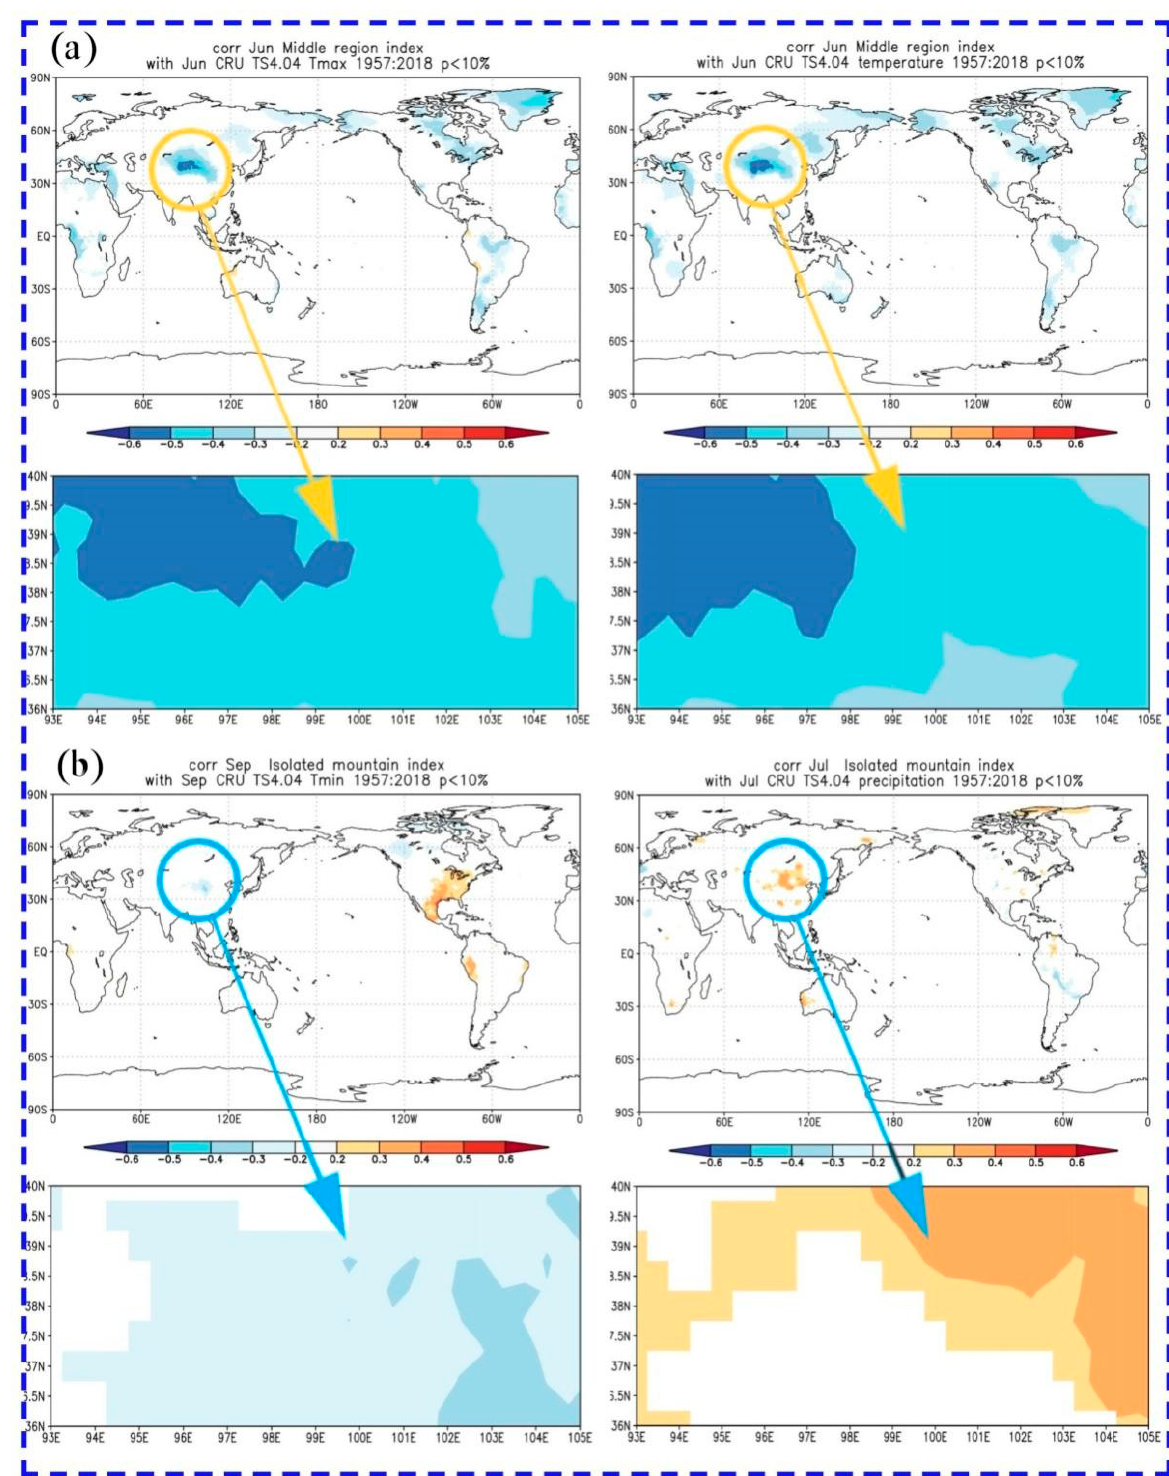
Figure 7. Spatial correlations between tree-ring width chronologies and main climate factors. The circles indicate that the approximate location of the study regions and the field correlations were p < 0.10 in all cases. ( a ) Central region, and ( b ) isolated mountains.